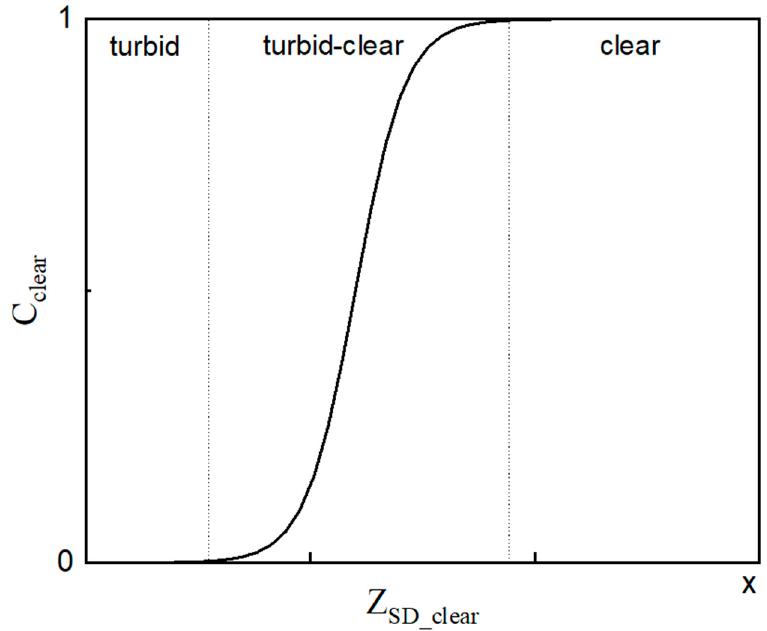
Figure 2. Logistic equation of coefficients of QAA_clear. The vertical dashed line represents the threshold value for switching models. The curve has three stages of change: the first only applies QAA_turbid, the second is when both models have contributions, and the third only uses QAA_clear.